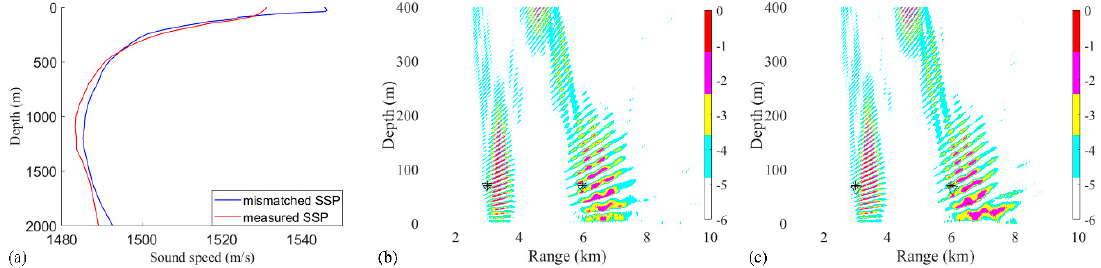
Figure 9. Effect of SNRs on the localization for the two-source case with SSR = 5 dB: ( a ) − 2 dB and ( b ) 2 dB. Probabilities of ( c ) depth estimation and ( d ) range estimation with different SNRs.